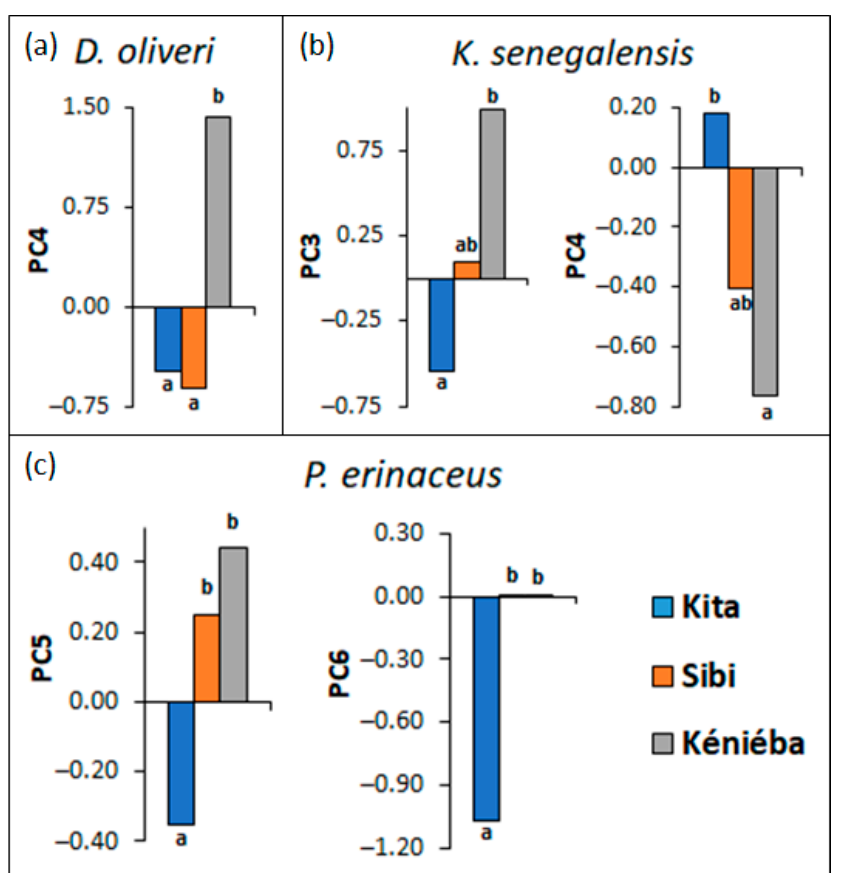
Figure 5. Bar chart of the mean values of component scores of PCA factors showing significant differences between samples from the three areas; ( a ) for D. oliveri ( n = 5 for Kita, n = 6 for Sibi and n = 6 for Kéniéba), ( b ) for K. senegalensis ( n = 8 for Kita, n = 8 for Sibi and n = 8 for Kéniéba), and ( c ) for P. erinaceus ( n = 6 for Kita, n = 5 for Sibi and n = 6 for Kéniéba); (the labels a, ab, and b refer to group classi fi cation in ascending order of the Student–Newman–Keuls post-hoc test).